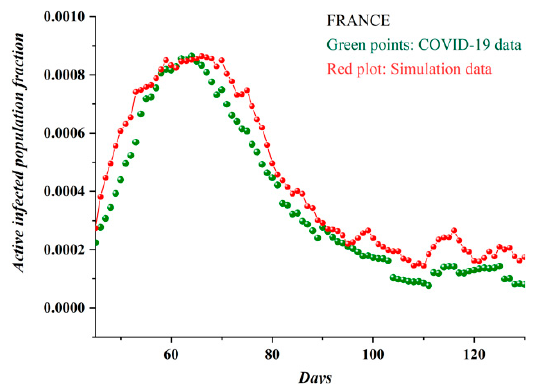
Figure 4. The COVID-19 epidemic data for France in green points, fitted by the proposed self-organized diffusion model (SODM) simulation data, in red points. Each day corresponds to 24 sweeps.